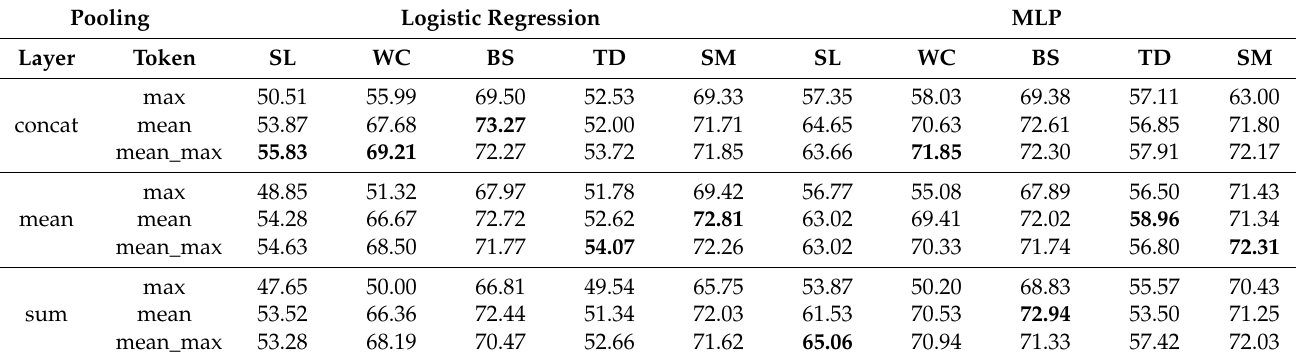
Table 9. Mean classification accuracy for sentence vectors derived using different pooling strategies (SL: SentLen, WC: WC, BS: BShift, TD: TreeDepth, SM: